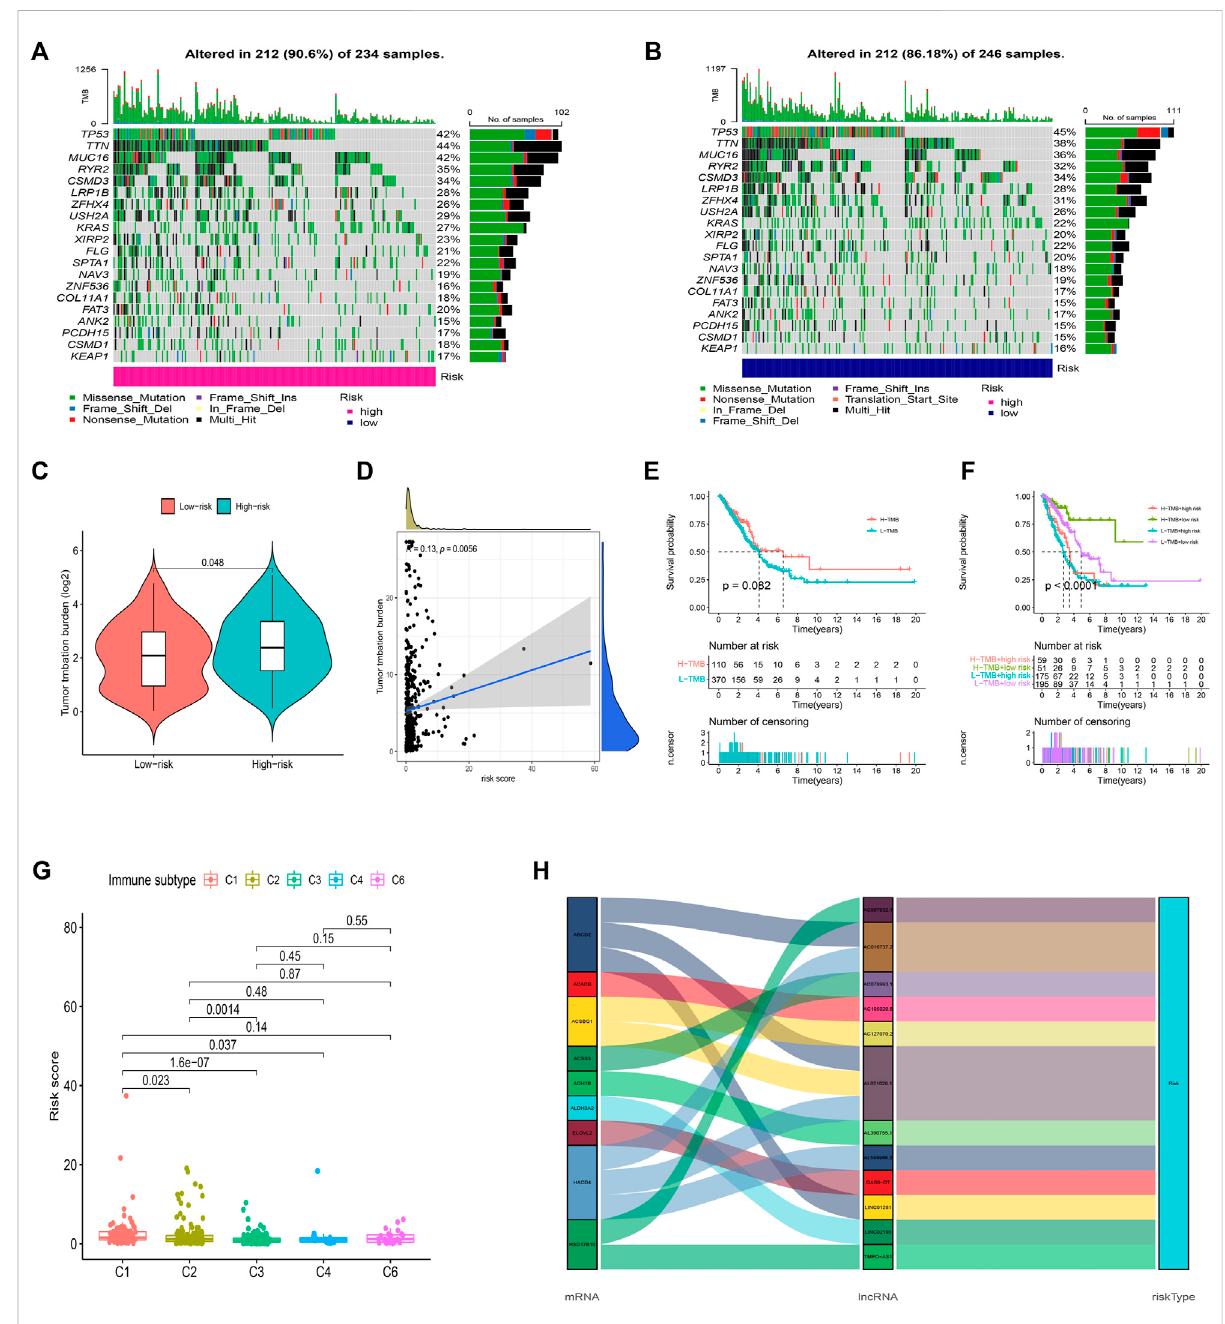
FIGURE 9 Exploration of TMB and lncRNAs networks visualization. (A , B) 20 genes with high mutation frequencies in different risk subgroups. (C) TMB differenceintworiskgroups. (D) ThecorrelationbetweenriskscoreandTMB. (E)